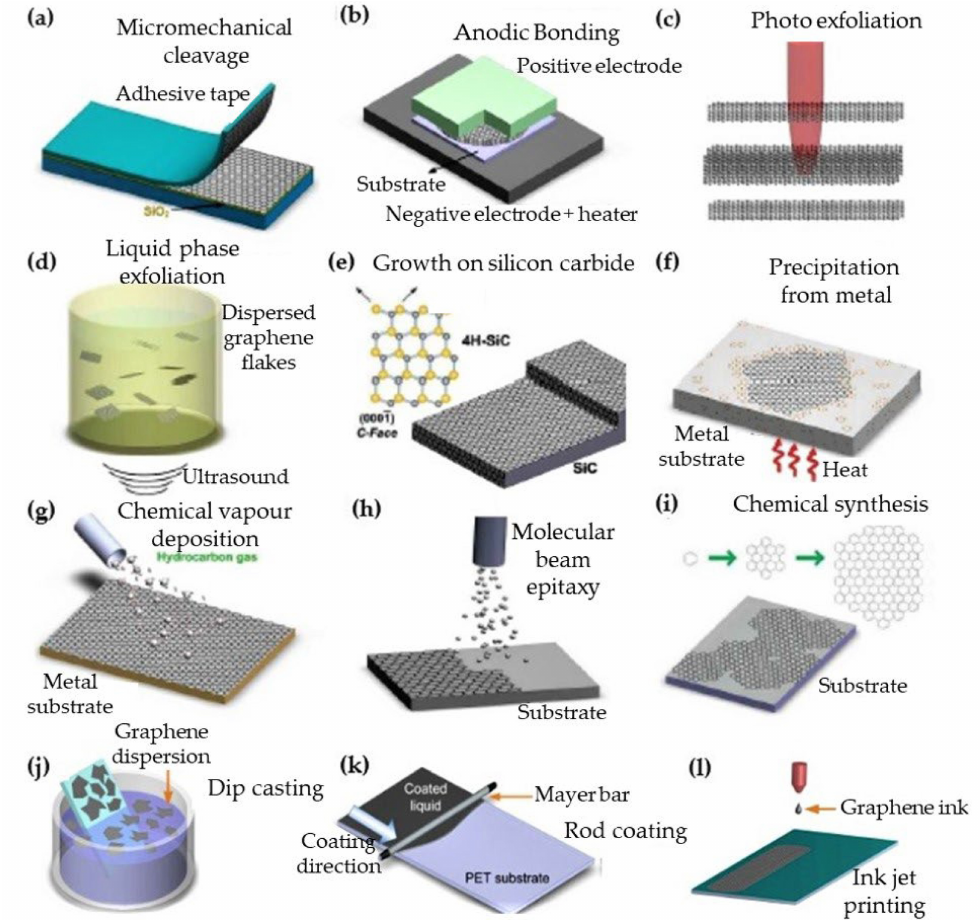
Figure 3. Graphene synthesis methods; ( a ) mechanical exfoliation, ( b ) anodic bonding, ( c ) photo exfoliation, ( d ) liquid phase exfoliation, ( e ) growth on silicon carbide, ( f ) precipitation from metal, ( g ) chemical vapor deposition, ( h ) molecular beam epitaxy, ( i ) chemical synthesis, ( j ) dip casting, ( k ) rod coating, and ( l ) ink-jet printing. Subfigures have been adapted/reproduced from reference [86] with permission from